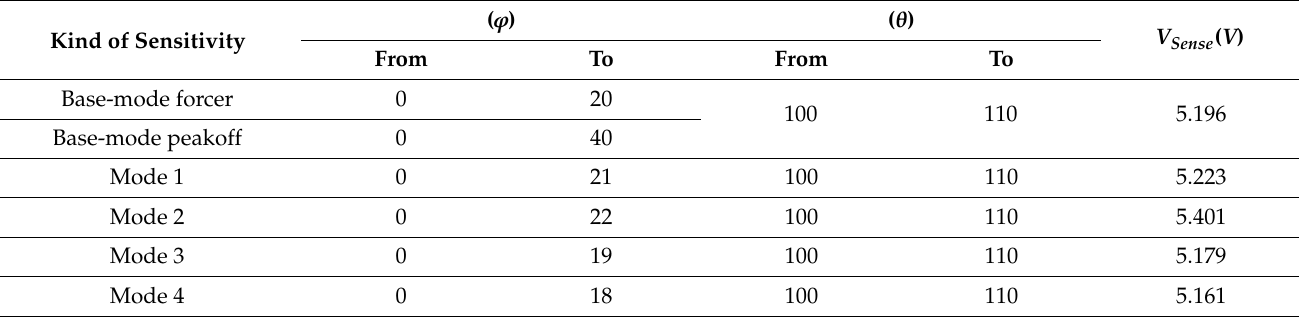
Table 7. Voltage sensed according to transverse location of electrodes (angle changes ( ϕ )).